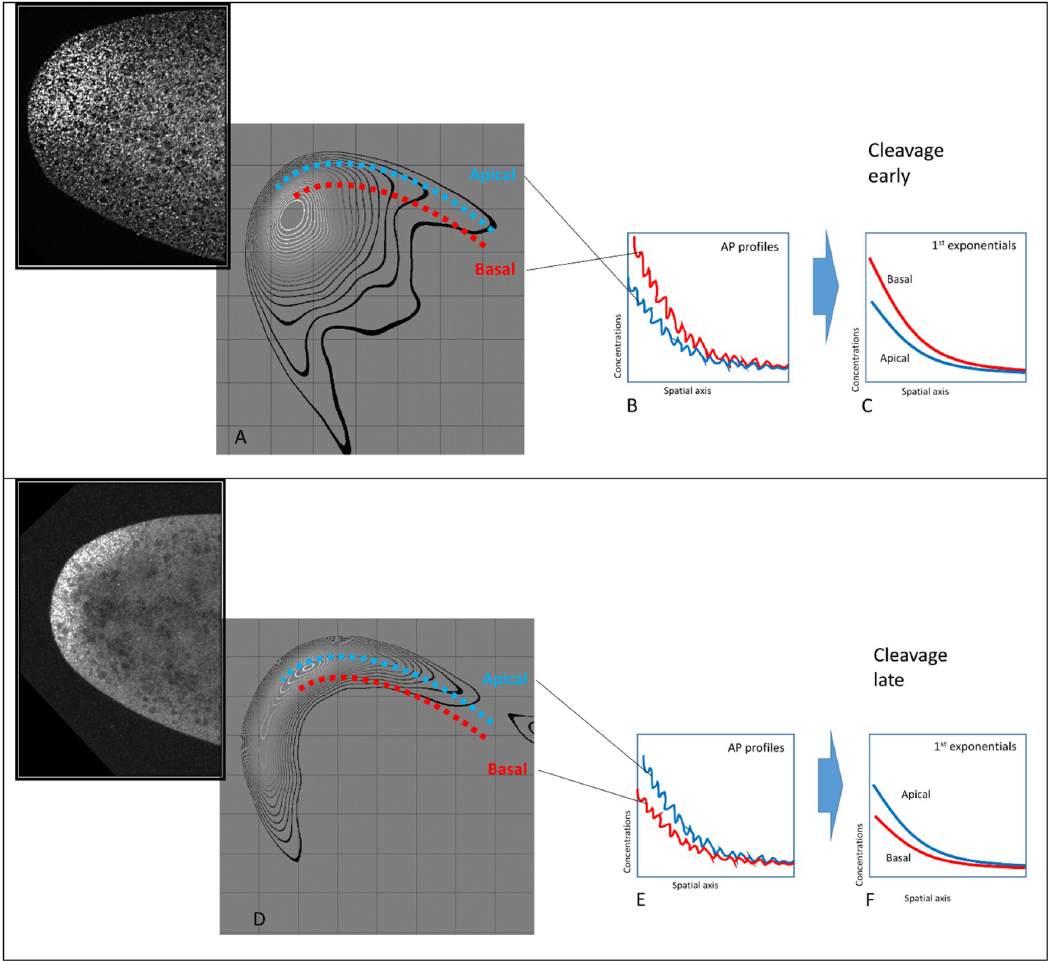
Fig 9. Correspondence between 2D analysis and 1D exponential parameters in showing bcd (and Stau) redistributions in the early (pre-blastoderm stage) embryo. When the bcd+Stau complexes are mainly in the interior of the head (with less material in the cortex, A), C apical ð Þ < C basal ð Þ (B to C). When bcd+Stau spreads to the posterior (D), l apical ð Þ and l basal ð Þ increase (both exponentials anterior anterior anterior anterior became shallower, E to F). The insets in A and B show raw bcd images of in the head of the embryo. 2.2.3 Syncytial blastoderm to cellularization. We again observe strong changes in the two-exponential parameters going into cellularization (cc14). In this case, the changes in developmental time are in the apical:basal intensity ratio; the lambda is relatively fixed at this time (i.e. the posterior-wards spread is halted). The developmental trajectory shows the apical intensity increasing steadily over this period (Fig 4C, for mean values). Fig 11 shows a clear separation of cc10-13 and cc14 groups by apical intensity, for both bcd mRNA and Stau (indi- cating coordinated underlying biology). This is a reversal of the decreasing apical intensity seen from Cleavage to syncytial blastoderm (Fig 4). 2 . 2 . 3 . 1 Signal redistribution in cc13 . The 26 embryos in the cc13 dataset are a large enough sample size to compare changes in 1D parameter profiles with redistributions visible in the 2D mid-sagittal plane. During cc 10–12, both bcd mRNA and Stau appear in a bright thin strip of the head cortical cytoplasm (not shown). Within even 12 minutes into cc13, it appears that these distributions are changing: in some images, both bcd mRNA and Stau are compact in